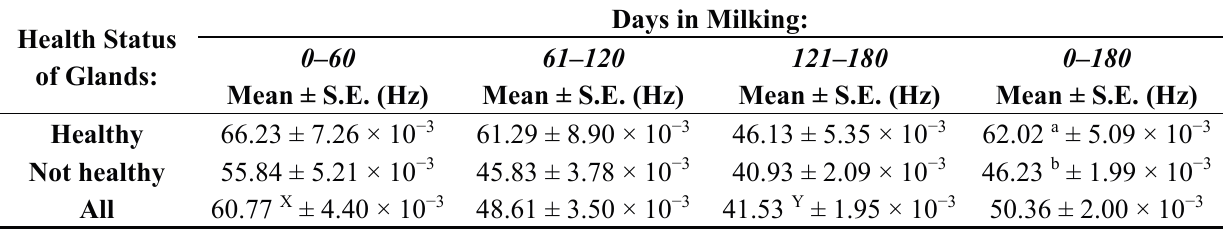
Table 8. Overall means and standard errors of the frequency of peak FFT_P 2 , according to health status and lactation stages.